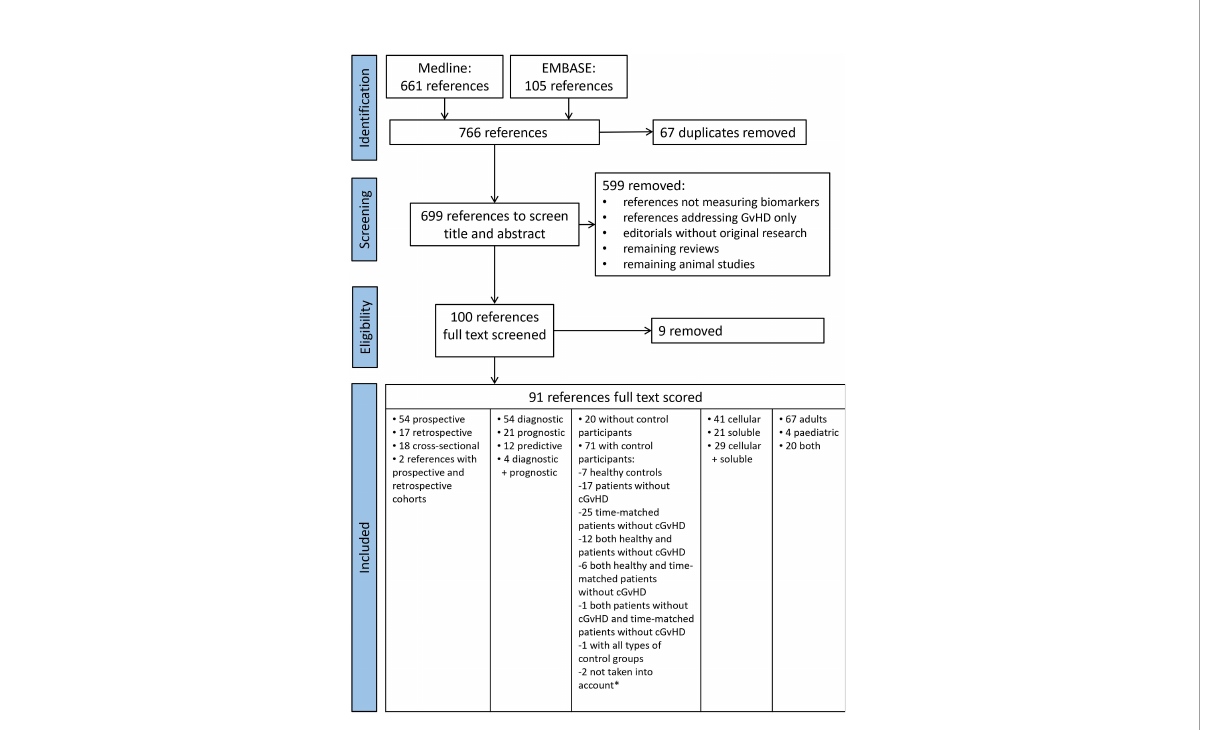
FIGURE 1 PRISMA Flow chart of literature search for cellular and soluble biomarkers of cGvHD. *Saad et al. (15) did not specify how many control subjects they had and Hirayama et al. (16) did an analysis of a subgroup of patients from their previous